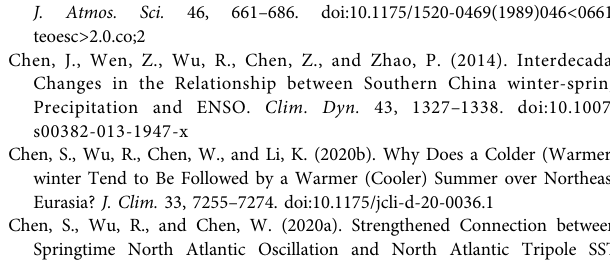
Frontiers in Earth Science |